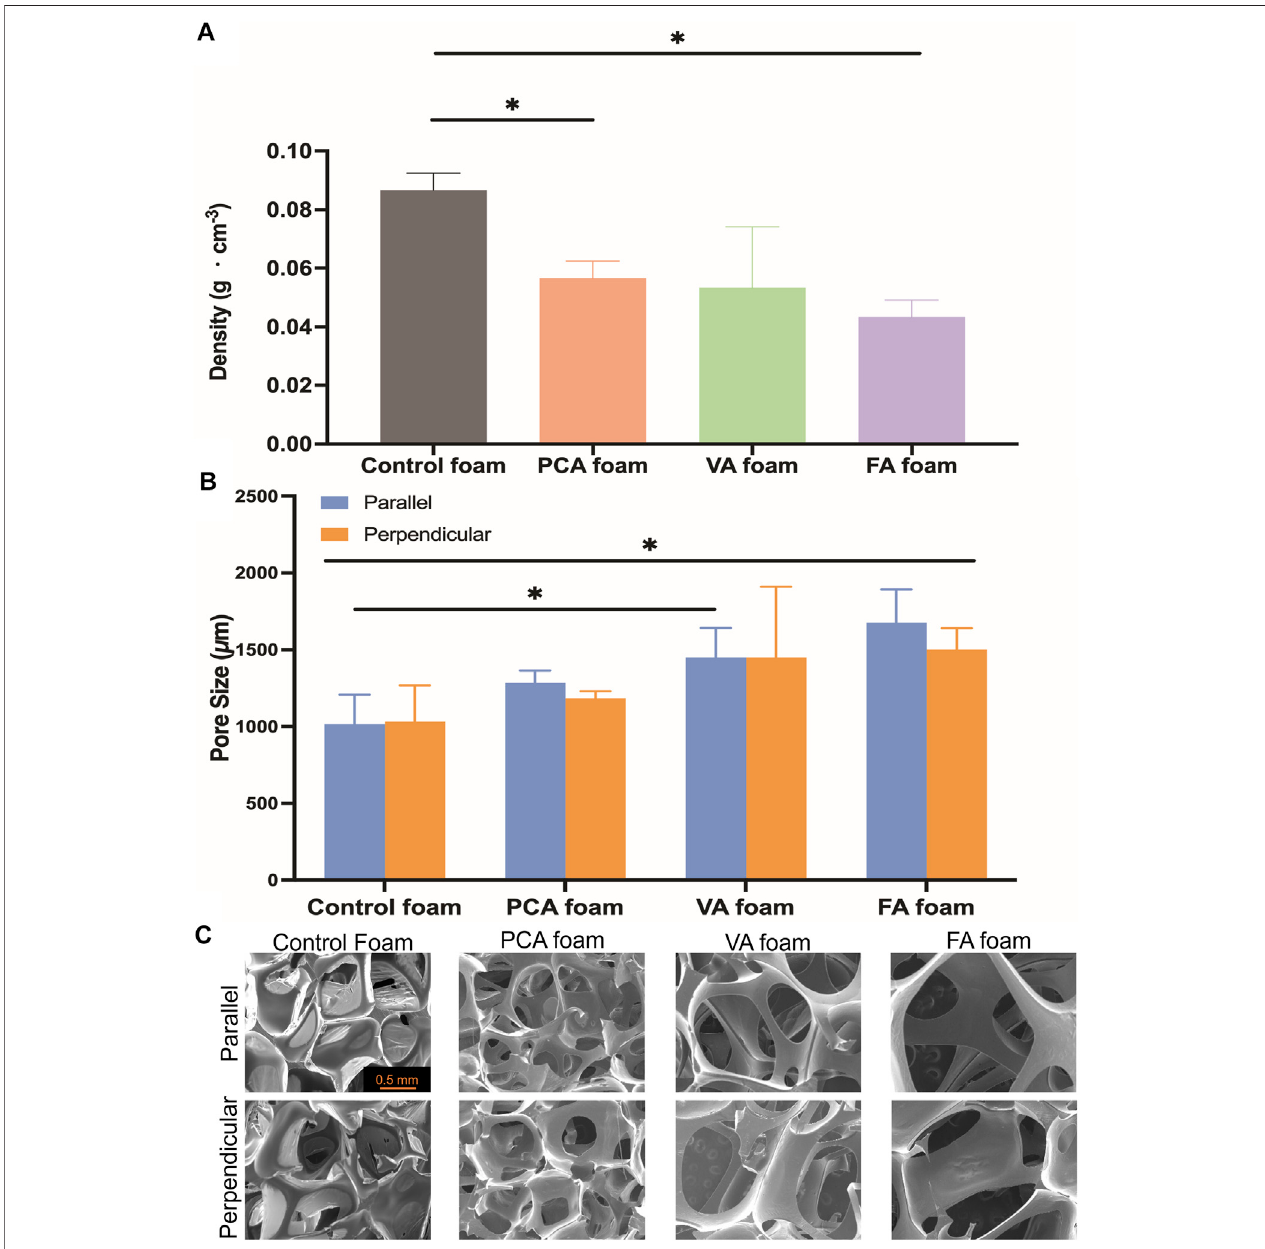
FIGURE 3 | Structural properties of PA-containing SMP foams. (A) Density; (B) Pore size (parallel and perpendicular to the foaming direction); (C) Scanning electron micrographs. Scale bar of 0.5 mm applies to all images. n = 3, mean ± standard deviation displayed, * p <